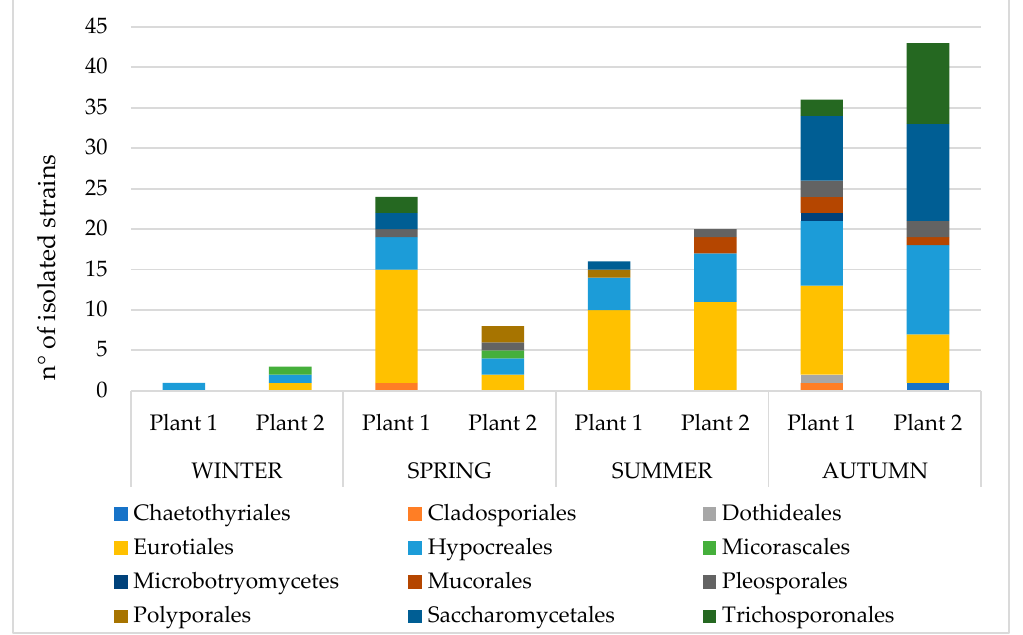
Figure 4. Seasonal variation of the isolated strains at an Order scale.